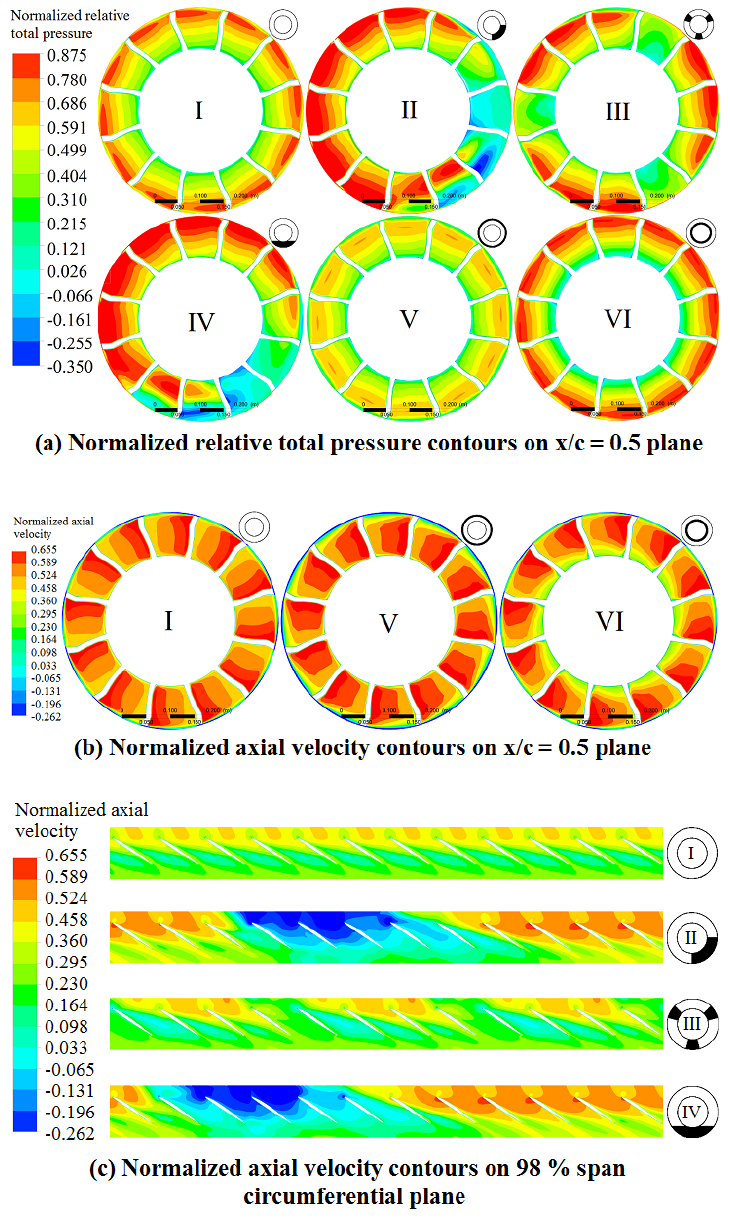
Figure 10. Flow fields for various distortion cases at design point